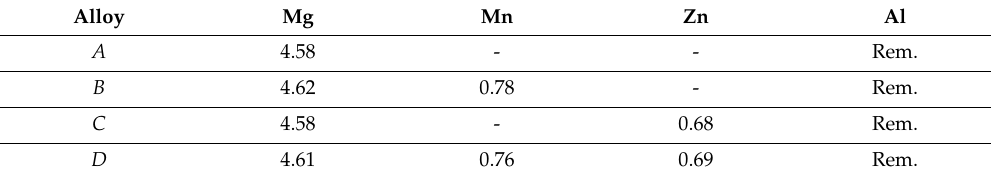
Table 2. Chemical compositions of experimental alloys